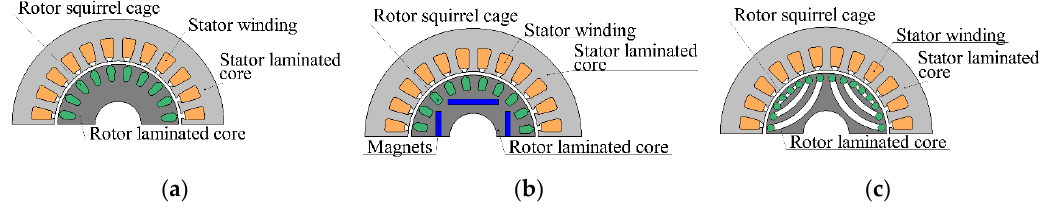
Figure 1. Schematic representation of motor geometry: ( a ) induction motors, (IM); ( b ) direct-on-line synchronous motor with permanent magnet in the rotor, (DOL-PMSM); ( c ) direct-on-line synchronous reluctance motor without permanent magnet (DOL-SynRM).